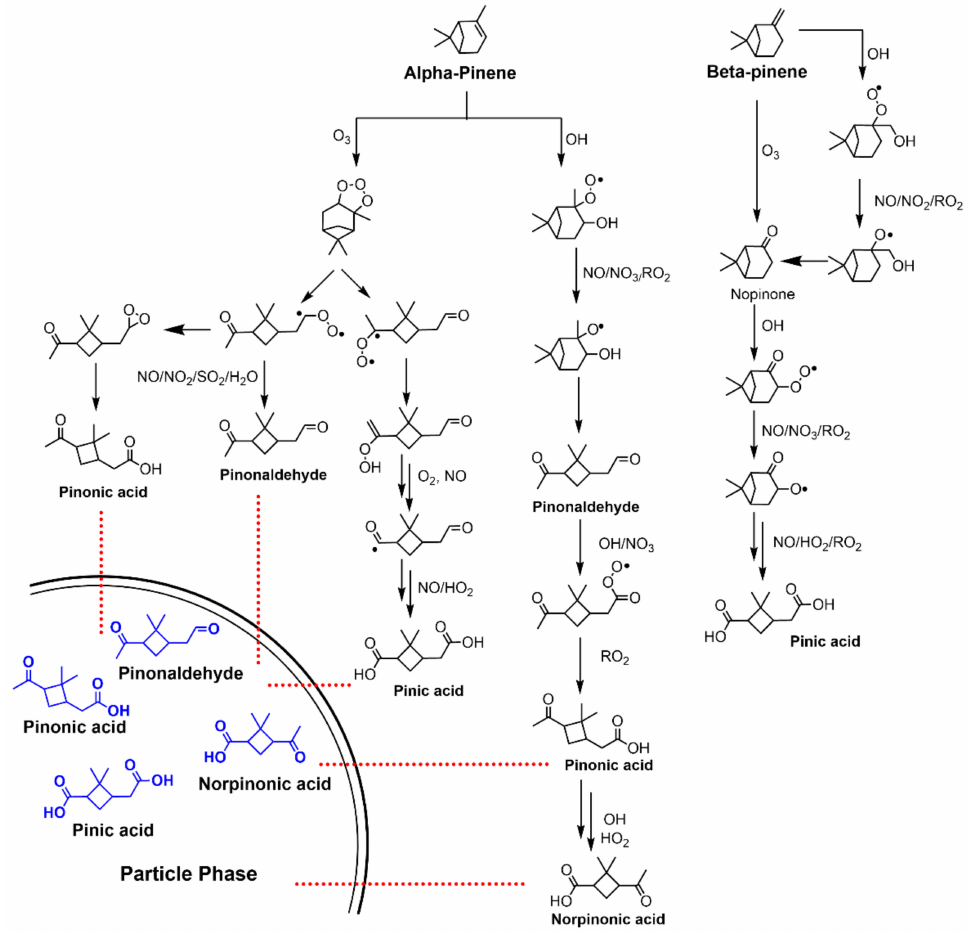
Figure 2. Near explicit production pathway of pinonaldehyde, pinonic acid, norpinonic acid, and pinic acid from the OH and O 3 initiated oxidation of α / β -pinene detailed in Master Chemical Mechanism